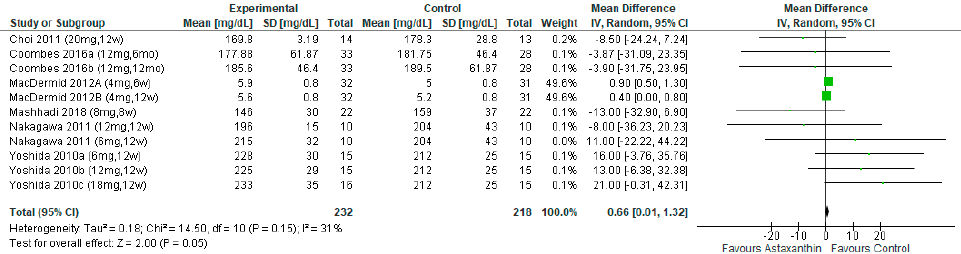
Figure 6. Forest plot of the effect of astaxanthin on total cholesterol [26–28,30–32]. Bold means total data.